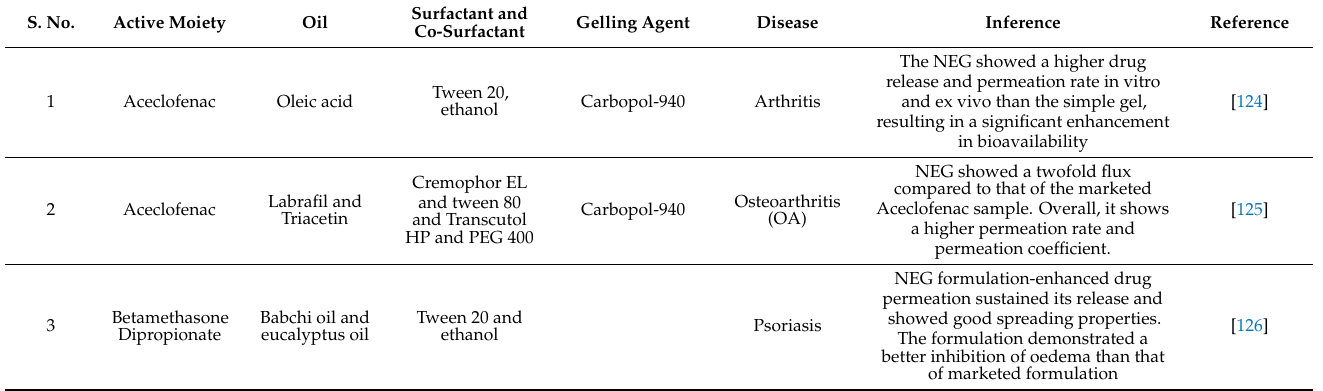
Table 3. Nanoemulgels containing synthetic anti-inflammatory